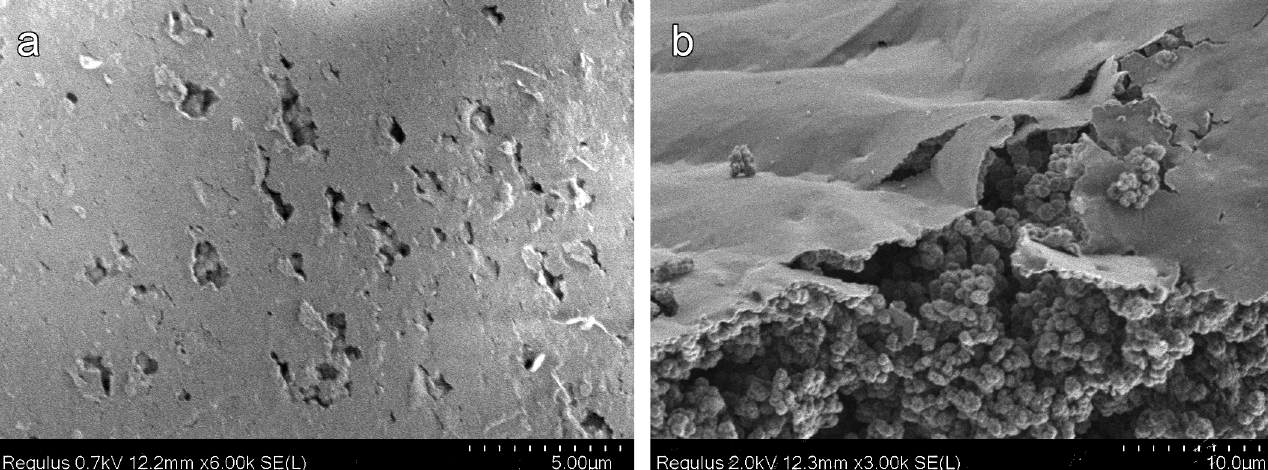
Figure 8. SEM micrographs of the film on the outer surfaces of porous monoliths: ( a ) M8 (25 wt % alcohol content) and ( b ) M13 (60 wt % alcohol content). alcohol content) and ( b ) M13 (60 wt % alcohol